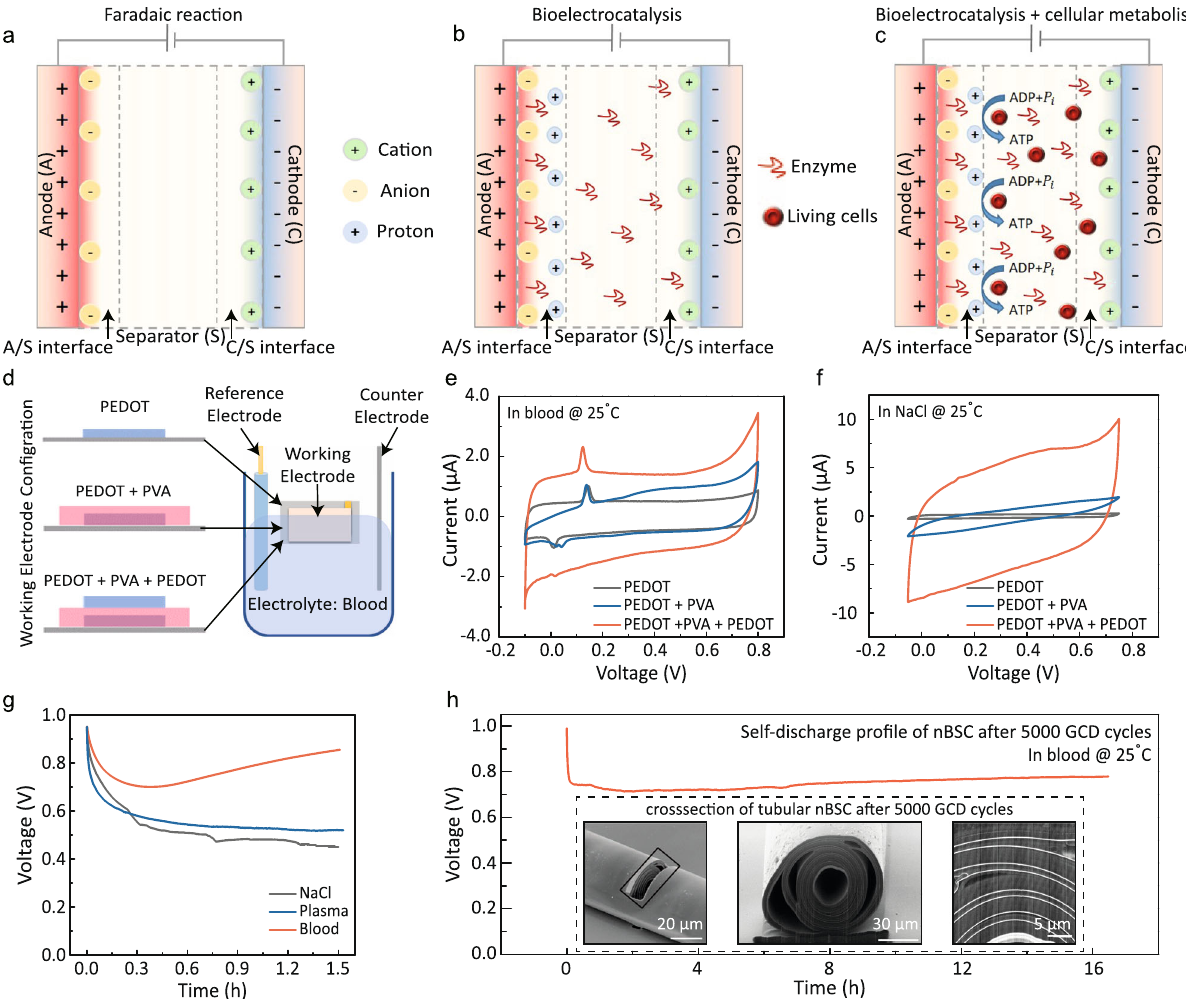
Fig. 2 Mechanism of bioenhancement in a nBSC. a – c Schematic illustration of ion transport and energy storage mechanism between two working electrodes in different electrolytes: a Faradaic reactions in presence of Na + and Cl - ions in medical saline. b Faradaic reactions coupled with bioelectrocatalysis due to the presence of enzymes in blood plasma electrolyte. c ATP synthesis coupled with bioelectrochemical reactions enhancing the electrochemical response of the nBSC in blood. d Schematic illustration of a three-electrode setup with a working electrode (the measured sample), reference electrode (Ag/AgCl) and counter electrode (platinum rod) to determine redox/catalytic reactions. e CV curve of various working electrode con fi gurations measured in blood electrolyte at a scan rate of 30 mV s (cid:1) 1 : f CV curve of various working electrode con fi gurations measured in NaCl electrolyte at a scan rate of 30 mV s (cid:1) 1 : g Self-discharge/self-charge of nBSCs under different electrolyte fl uids for 1.5 h. h Self-discharge pro fi le in blood after 5000x GCD cycles. Inset shows cross-sectional images of tubular nBSC after 5000x GCD cycles. (All measurements are performed under ambient condition at 25